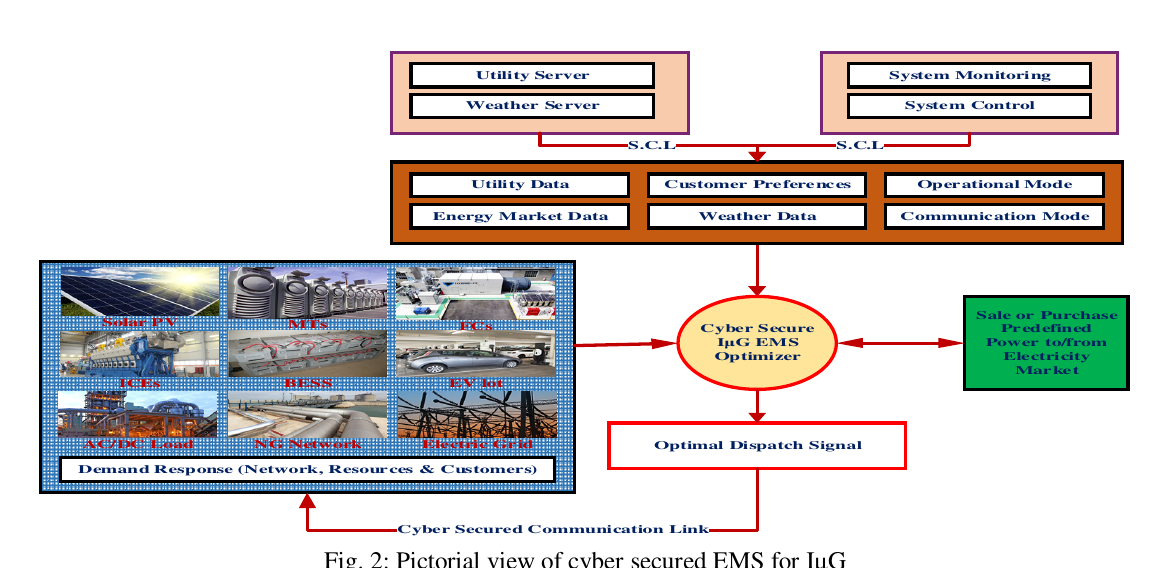
Fig. 2: Pictorial view of cyber secured EMS for I μ